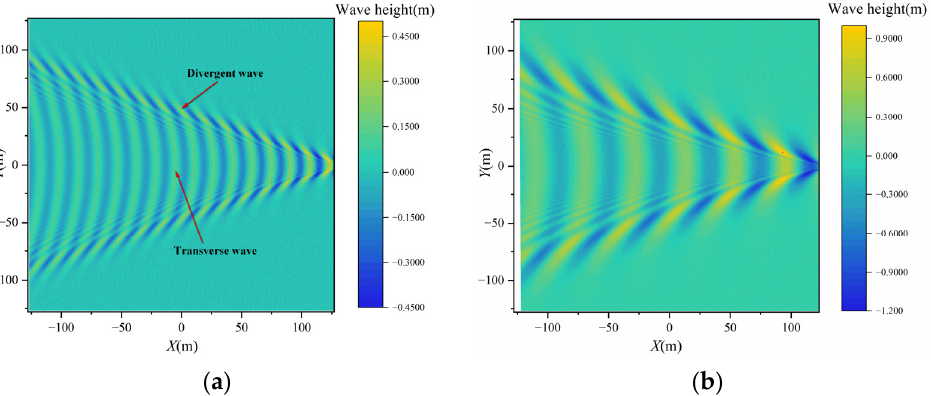
Figure 3. Simulation results of Kelvin wake height. ( a ) The ship speed is 5 m/s; ( b ) The ship speed is 8